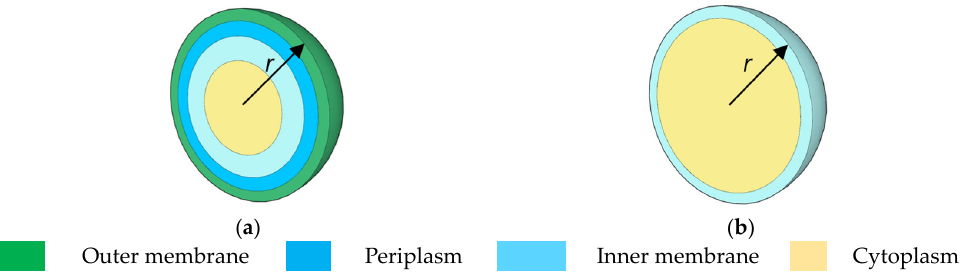
Figure 1. Topological model of spherical ( a ) live and ( b ) dead E. coli bacterium [25,26].